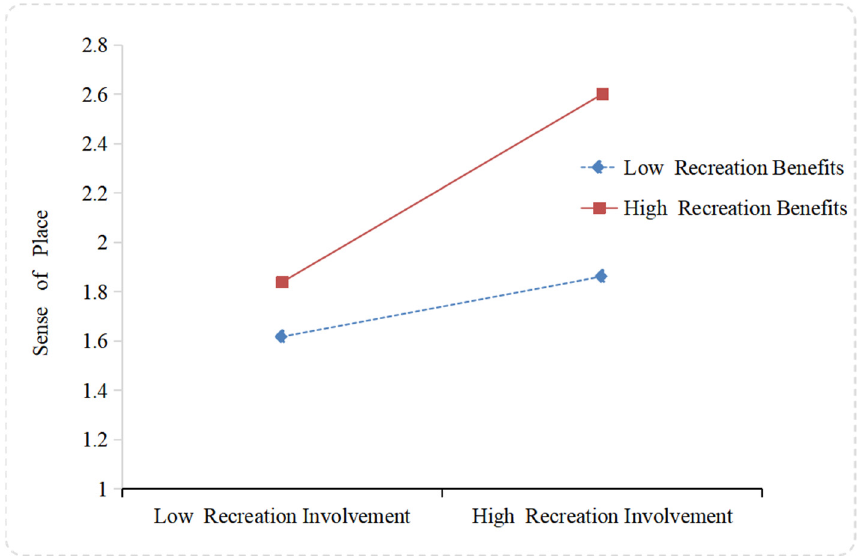
Figure 4. Moderating effect of recreation benefits on the relationship between recreation involvement and sense of place. and sense of